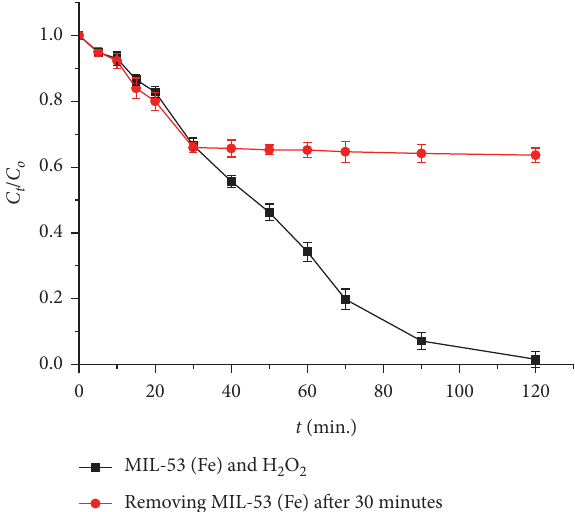
Figure 14: Leaching experiments (experimental conditions: 0.5g/L of catalyst; 80mg/L RhB; 0.096M H 2 O 2 ; 30 ° C, pH